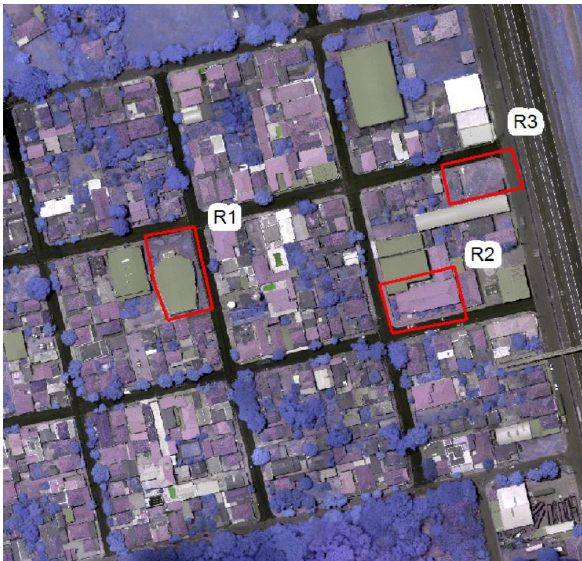
Figure 2. Test site and selected regions (R1, R2 and